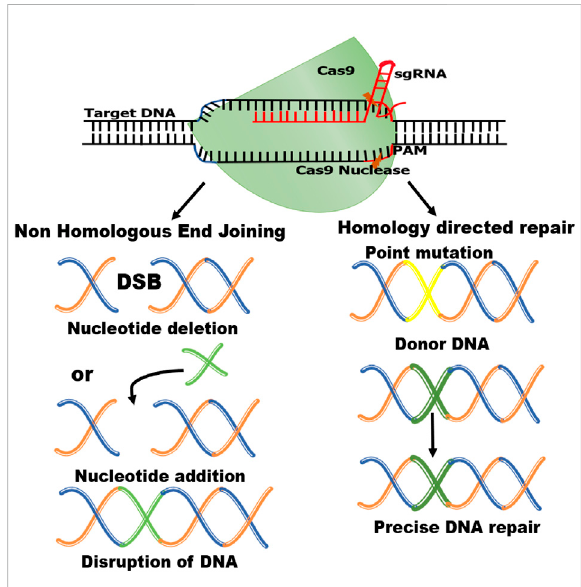
FIGURE 2 Schematic diagram of CRISPR/Cas9 mechanism. Double- strand breaks (DSBs) are induced when Cas9 enzyme and gRNA